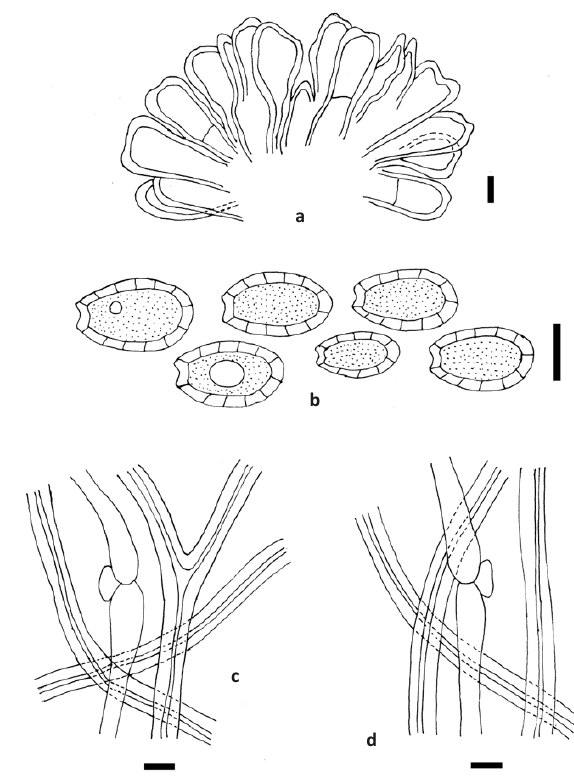
Figure 4. Ganoderma ahmadii . a - hyphae of the cutis, b - basidiospores, c - context hyphae, d - tube layer hyphae. Bars = 5µm. Drawing by R.